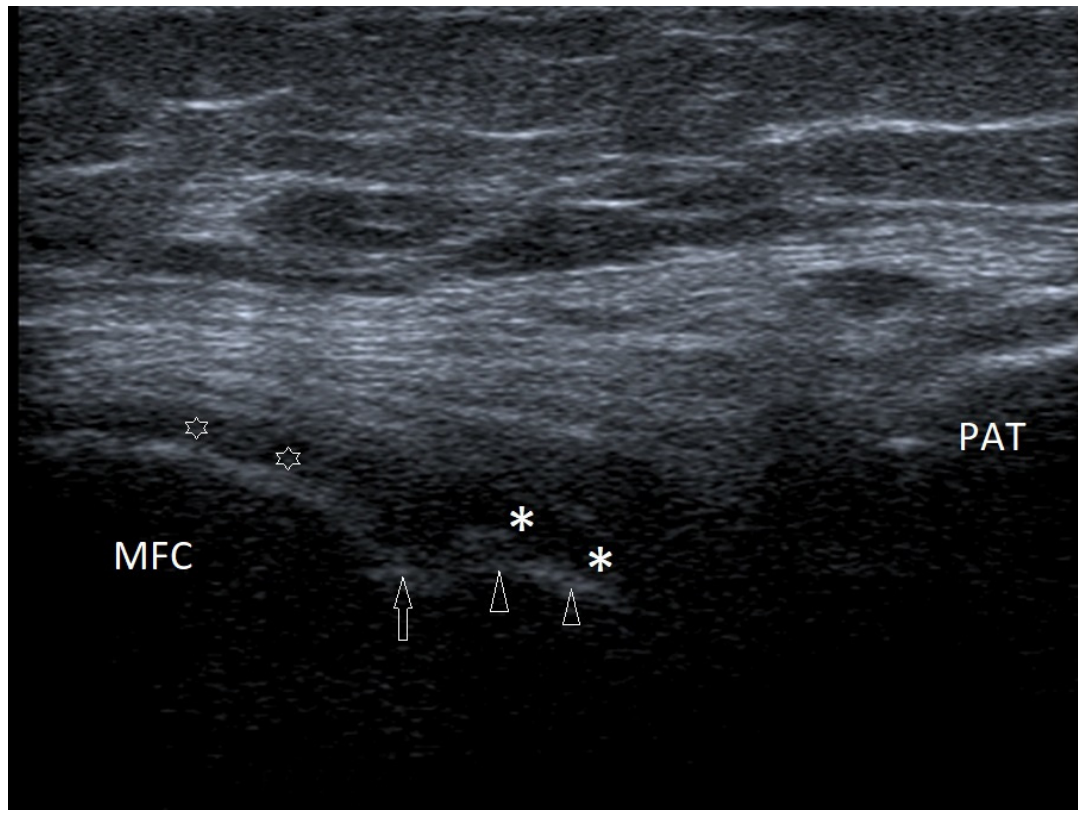
Figure 8. A case of OCD in a 15-year-old boy. Cross-section at the level of the medial femoral condyle (MFC); arrow—break in the subchondral bone at the edge of the OCD lesion; arrowheads— subchondral bone in the OCD zone; asterisks—swollen cartilage in the OCD zone; empty stars— cartilage covering the healthy part of the MFC, also with symptoms of slight swelling (increased echogenicity and slightly increased thickness); PAT—patella. Linear probe 7–18 MHz.